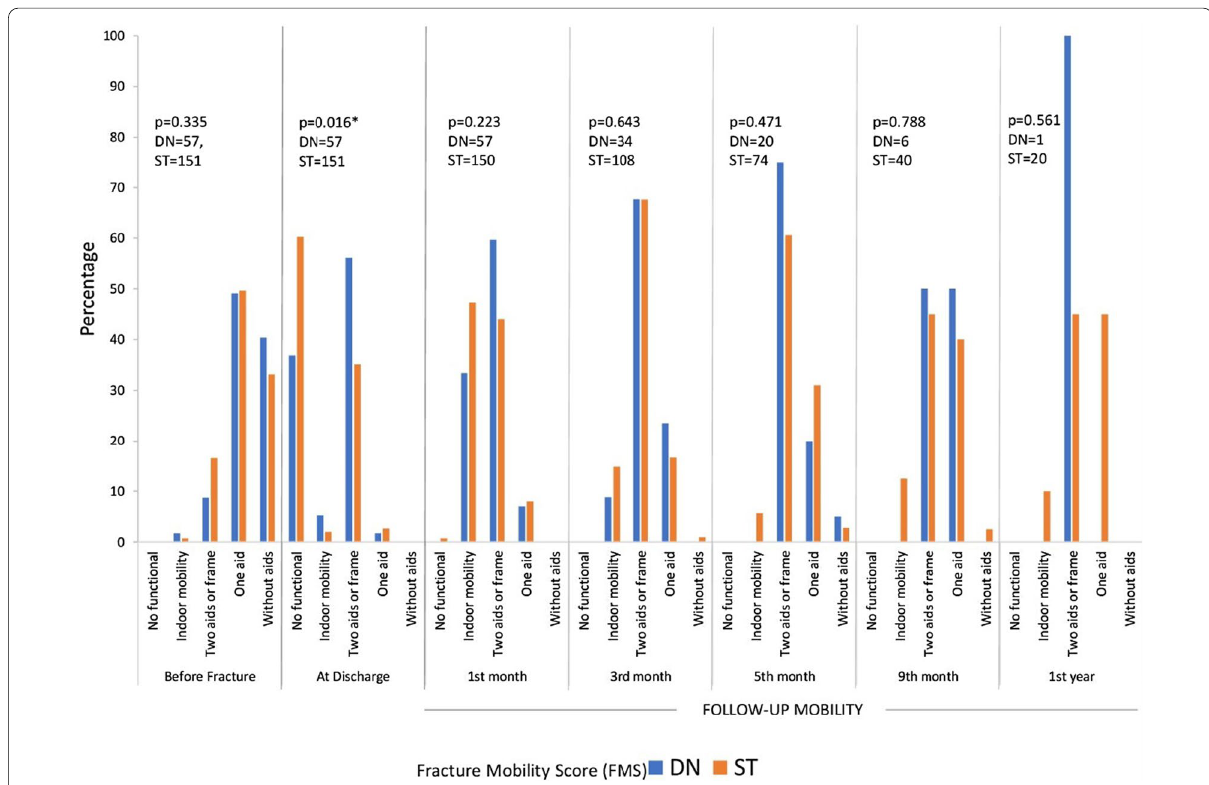
Fig. 2 Patients’ mobility (Fisher’s exact test). FMS, Fracture Mobility Score